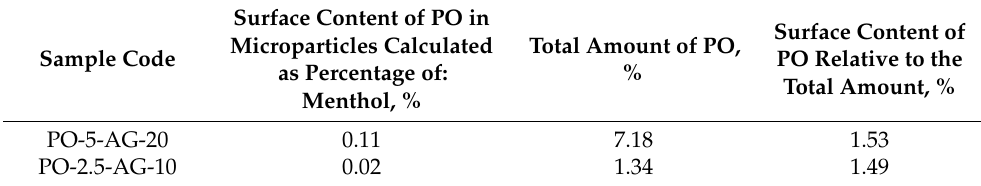
Table 4. Surface content and total amount of peppermint oil in microparticles.